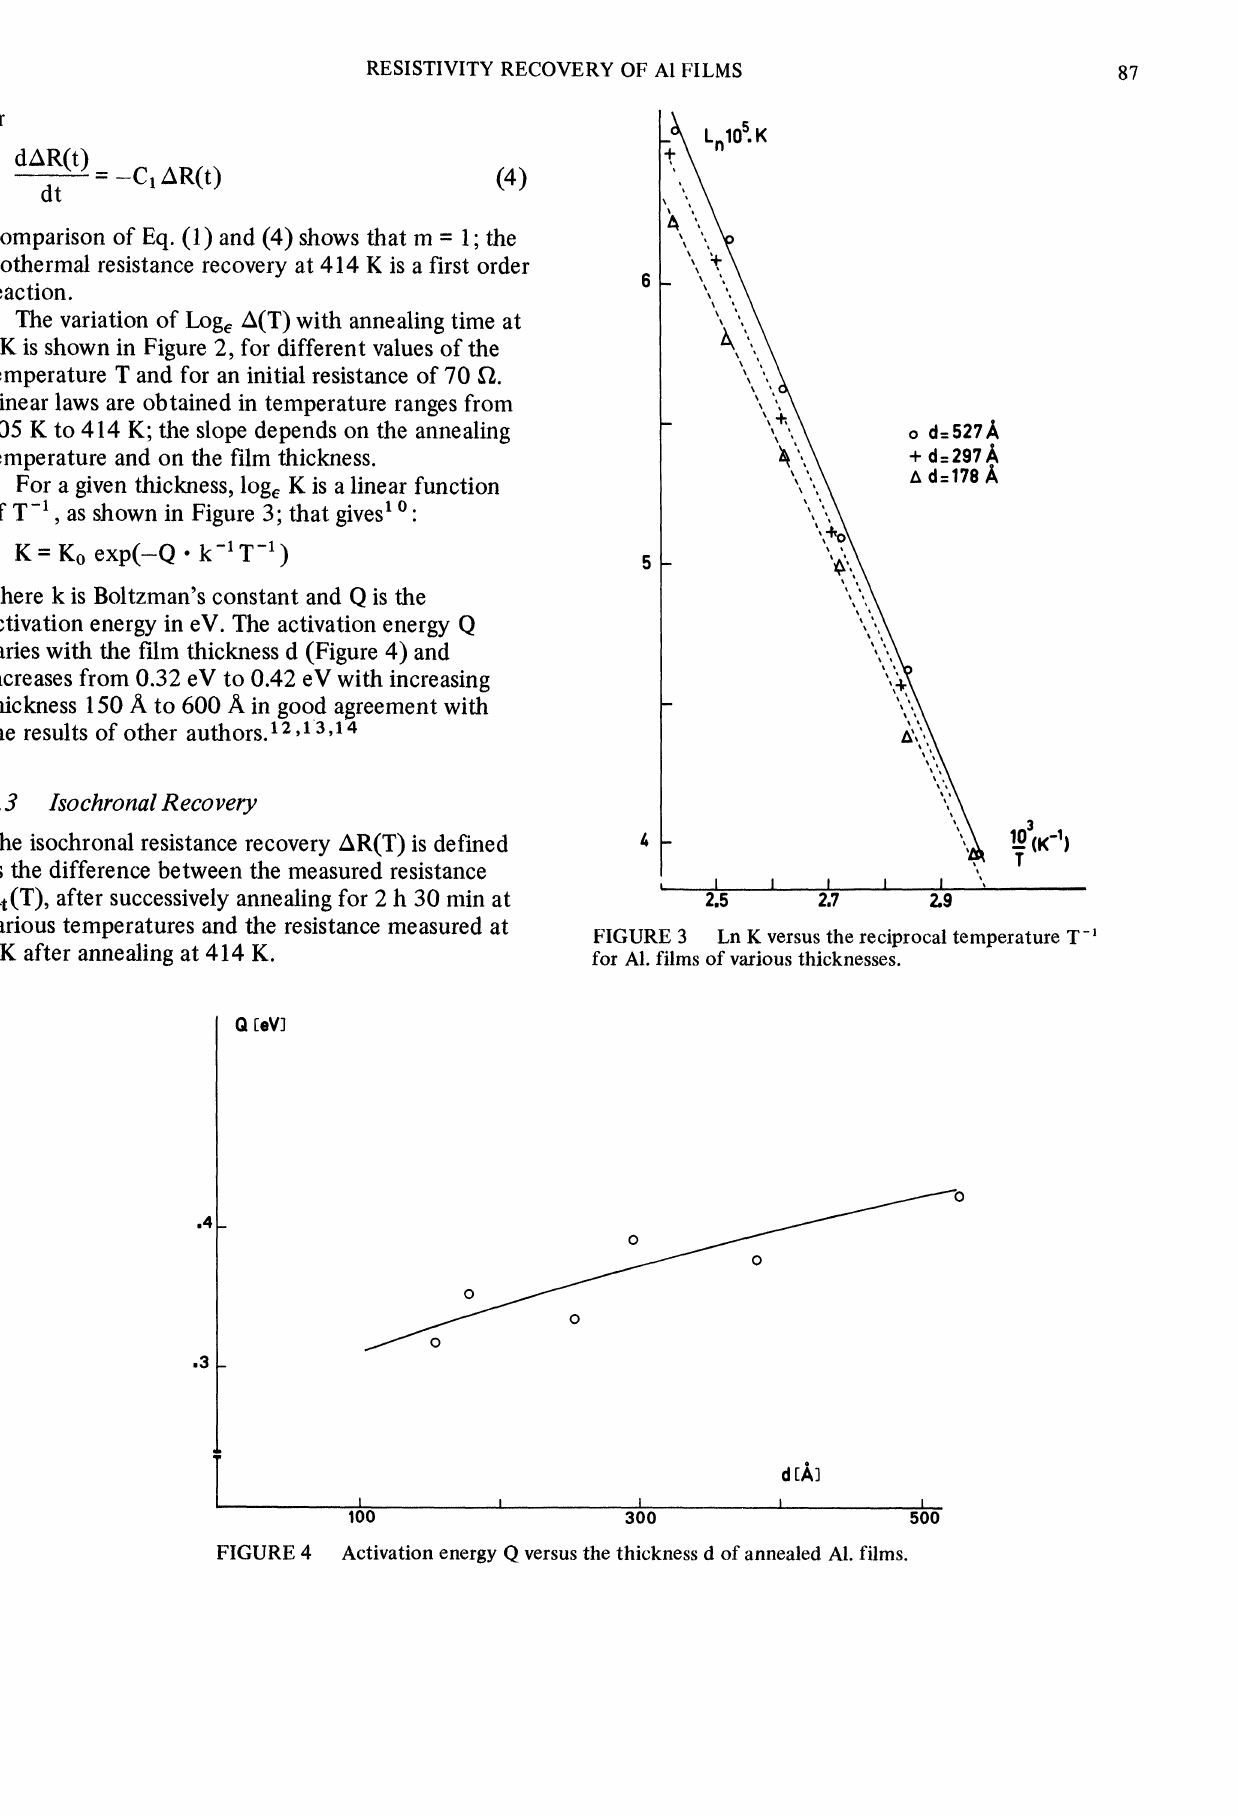
Activation energy Q versus the thickness d of annealed A1.